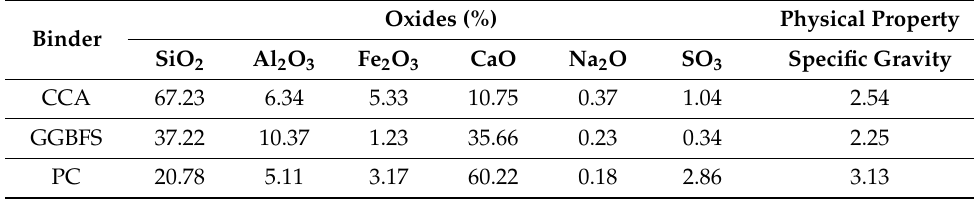
Table 1. Oxide compositions of PC, GGBFS, and